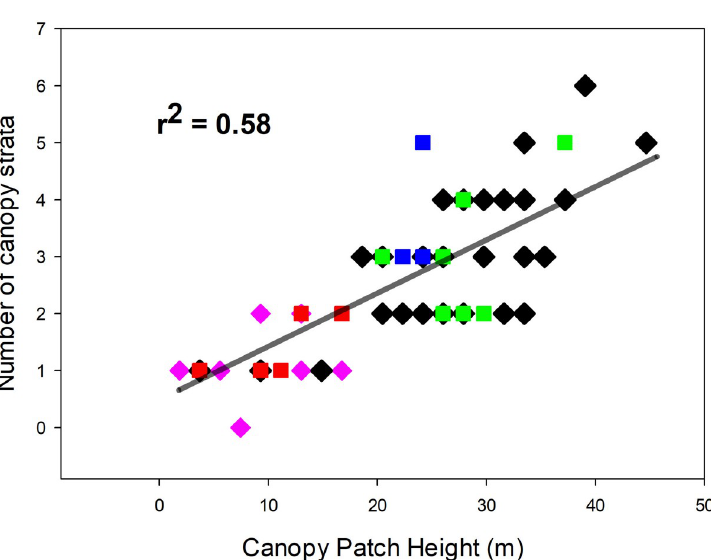
Fig 2. Number of canopy strata as a function of canopy height across a gradient of tropical forest succession at La Selva Biological Station, Costa Rica. Data from 18-yr-old secondary forest are shown in red squares, 25-yr-old sites in blue squares, 35-yr-old sites in green squares, black diamonds are 45 random patches in old growth, and pink diamonds are 10 old-growth patches selected for canopy height < 16 m.